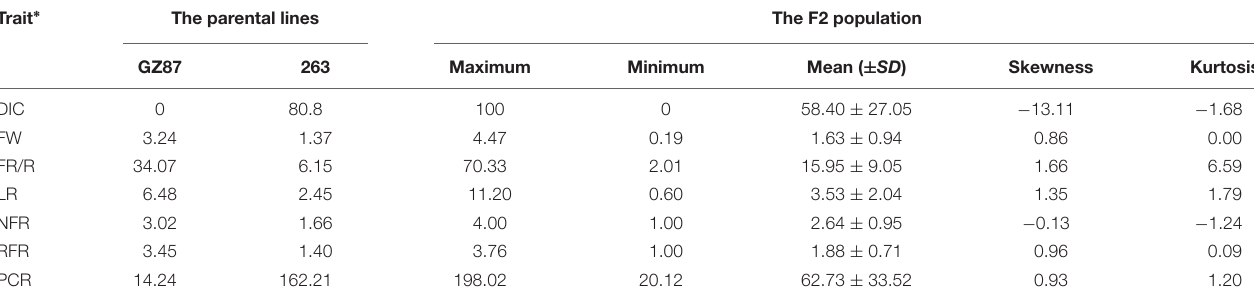
FIGURE 1 | The root morphology of ‘GZ87’ and ‘263’ after infection by Plasmodiophora brassicae under field (A) and lab (B) assays. TABLE 1 | The phenotypic performance of clubroot resistance associated traits in the parental lines and the F2 population of Brassica